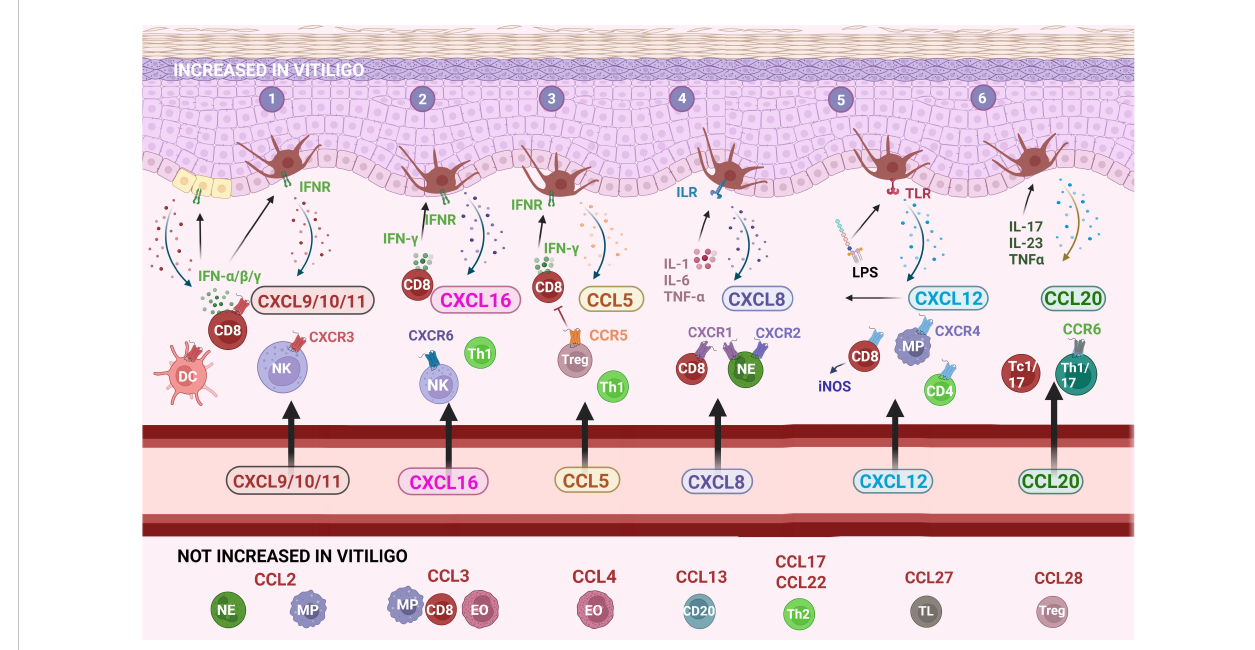
FIGURE 2 The main chemokines and receptors and their recruitment of immune cells into vitiligo skin. (1) CXCL9/10/11 chemokines bind to the CXCR3 receptor that plays a key role in the development of a cytotoxic CD8 response via IFN- g ; (2) CXCL16-CXCR6 signaling recruits NK cells, CD8 and CD4 lymphocytes; (3) the CCL5-CCR5 pathway attracts a broader range of immune cells into the skin; (4) CXCL8 is mostly recognized for its effect on neutrophils although a subset of CD8 lymphocytes also responds to this chemokine; (5) CXCL12 recruits several immune cells including macrophages and NK cells and also stimulates melanocyte migration; (6) CCL20 possibly involved in the recruitment of Tc1/17 and Th1/17 towards the skin. CCL: chemokine (C-C motif) ligand; CCR: chemokine (C-C motif) receptor; CD: cluster of differentiation; CXCL: chemokine (C-X-C motif) ligand; CXCR: chemokine (C-X-C motif) receptor; DC: dendritic cell; EO: eosinophil; IFN: interferon; IFNR: interferon receptor; IL: interleukin; ILR: interleukin receptor; iNOS: inducible nitric oxide synthase; LPS: lipopolysaccharides; MP: macrophage/monocyte; NE: neutrophil; NK: natural killer cell; Tc: cytotoxic T lymphocyte; Th: T helper lymphocyte; TL: skin-homing T lymphocyte; TLR: Toll-like receptor; TNF: tumor-necrosis factor; Treg: regulatory T cells. Created with